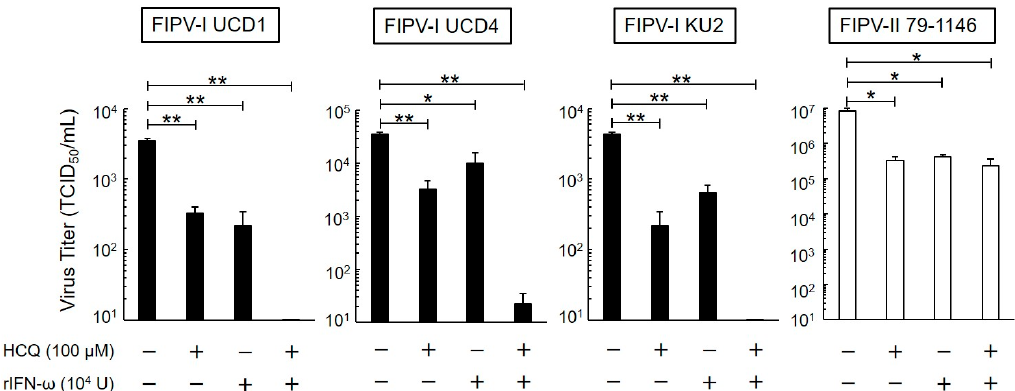
Figure 3. Effects of 1-h exposure on antiviral activity of HCQ and rfIFN- ω . Virus titer of FIPV-infected fcwf-4 cells pre-treated with HCQ (100 µ M) and rfIFN- ω (10 4 U / mL) for 1 h. The results are shown as the mean ± SE. Data represent four independent experiments. ** p < 0.01 (* p < 0.05) vs. untreated (pre-treated with medium only).